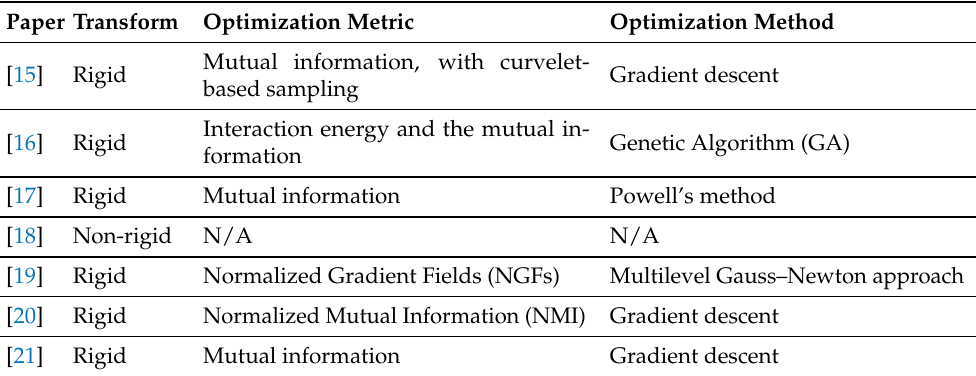
Table 3. Articles about multi-modal image registration methods. Paper Transform Optimization